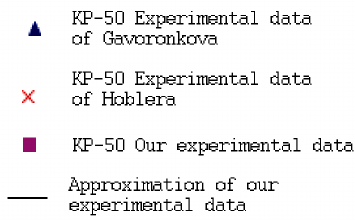
Fig. 9. Comparison of our experimental data with the results of experiments of Gavoronkova and Hoblera